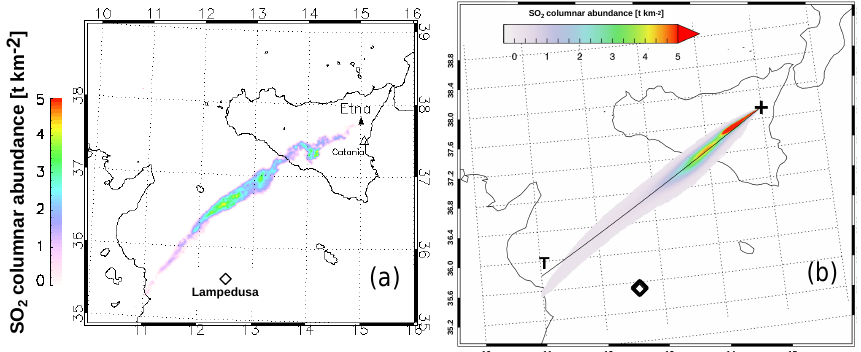
Figure 5. (a) Sulfur dioxide column abundance (in tkm − 2 – tons per square kilometre) derived from Aqua-MODIS overpass of 26 Oc- tober 2013, 12:20. The position of Lampedusa is indicated with a black diamond. (b) Sulfur dioxide column abundance (in tkm − 2 ) from FLEXPART simulations, for 26 October 2013, 12:20 UTC. Violet–grey to red pixels indicate relatively low to high abundance values. The position of Lampedusa is indicated with a black diamond; the position of Mount Etna is indicated with a black cross; the trajectory T is representative of the plume axis.